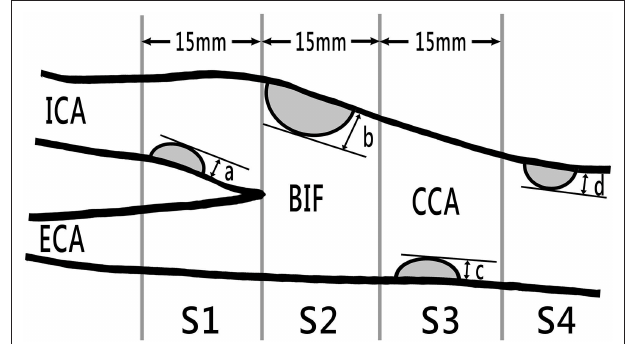
FIGURE 1 | Carotid plaque scores obtained through B-mode sonography. The total plaque score was computed by summing the maximum plaque thickness (in millimeters) a in segments S1 (internal carotid artery within 15mm distal of bifurcation), b in S2 (region of internal and distal common carotid artery within 15mm proximal of bifurcation), c in S3 (common carotid artery 15–30mm proximal of bifurcation), and d in S4 (common carotid artery > 30mm distal of bifurcation) on both sides. BIF, bifurcation; CCA, common carotid artery; ECA, external carotid artery; ICA, internal carotid